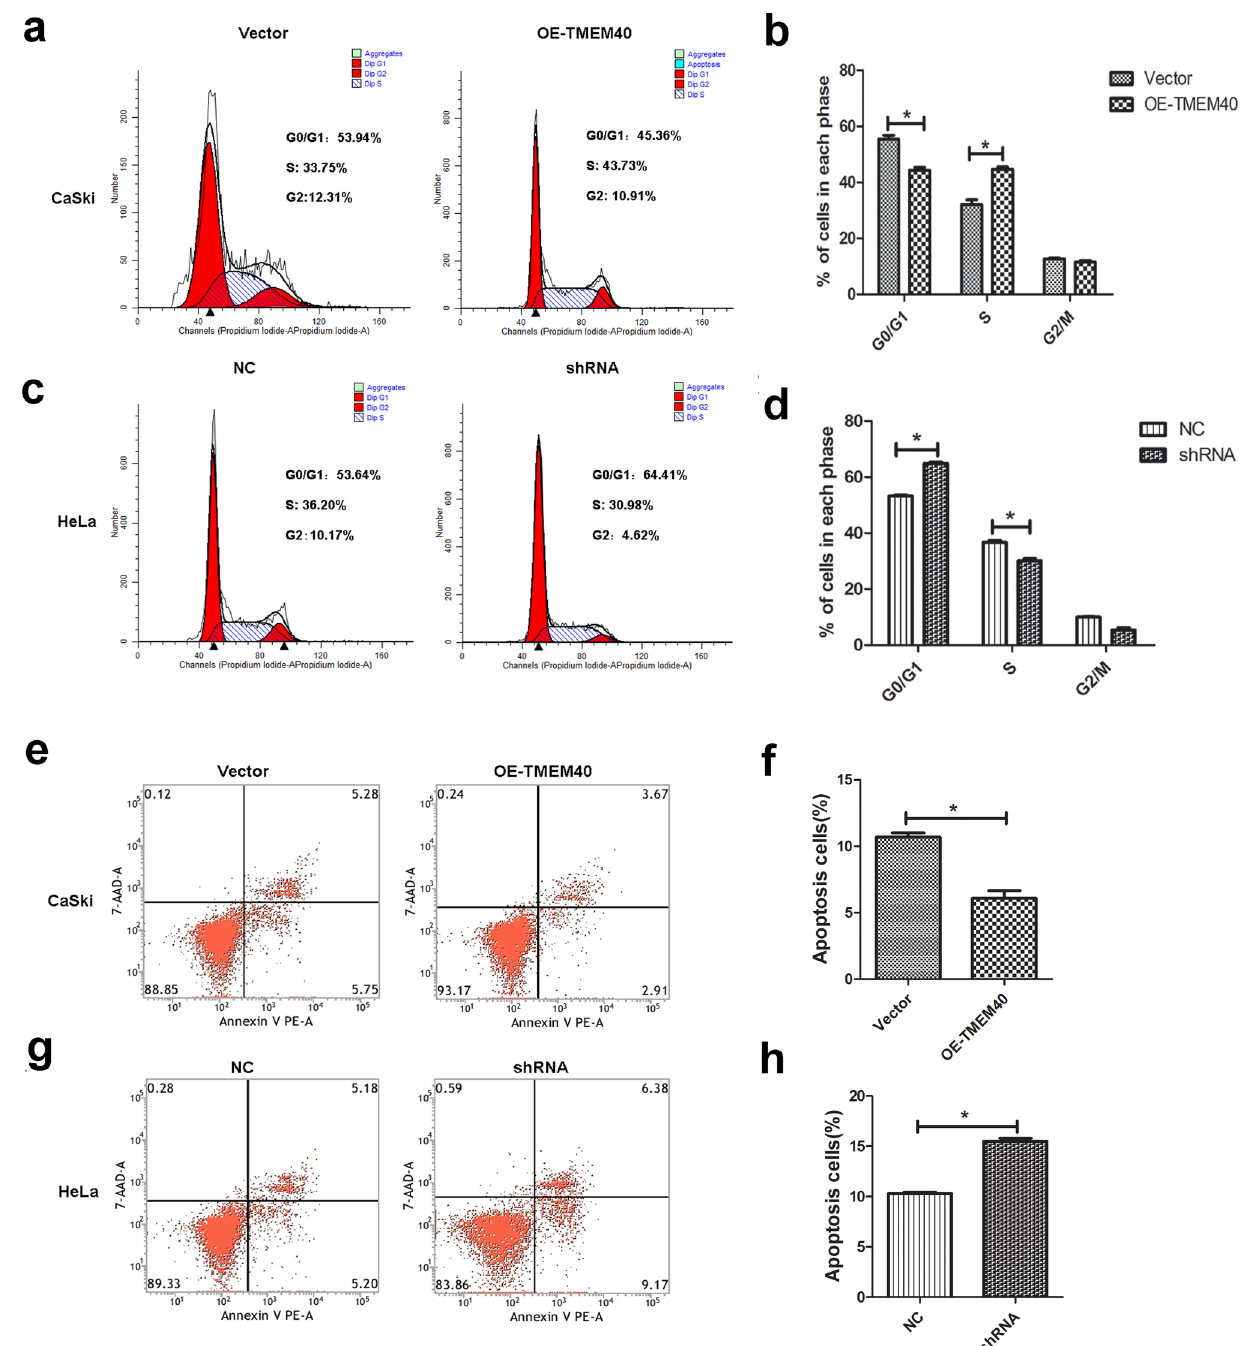
Fig. 5 TMEM40 regulates CC cell cycles and apoptosis in vitro. a-b and c-d , Cell cycle analysis determined the relative cell numbers in each cell-cycle phase after propidium iodide staining of OE-TMEM40 or TMEM40 shRNA transfected CaSki and HeLa cells. e – f and g - h , Flow cytometry assays were performed to determine apoptotic cells after 48 h transfection with OE-TMEM40 or TMEM40 shRNA compared to their controls. * P <